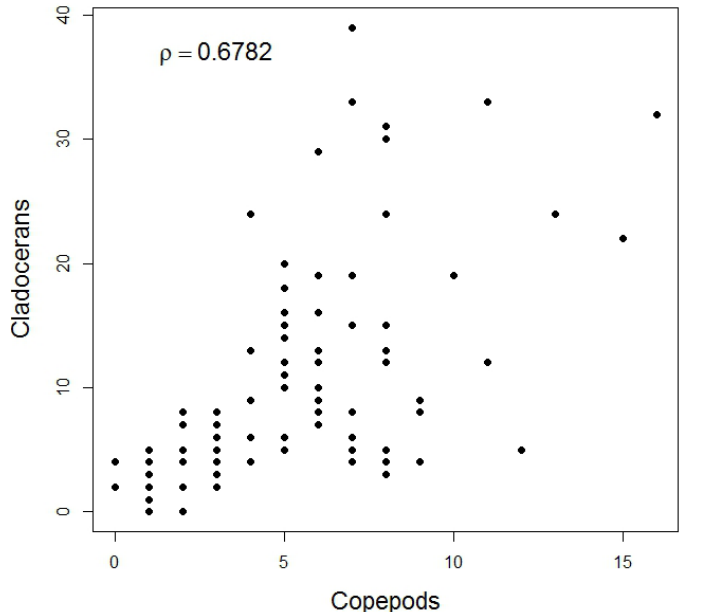
Figure 2. Conjunct distribution of species richness of copepods and cladocerans ( ● , black circles) and Spearman coefficient pointing a positive association (p < 0.001) for these